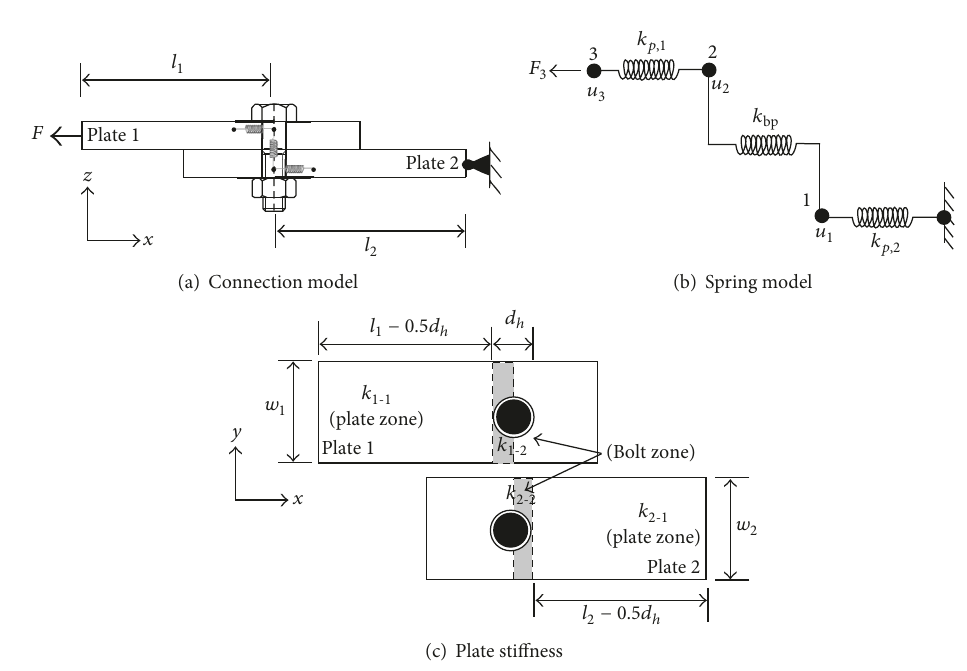
Figure 17: The spring model of single bolt